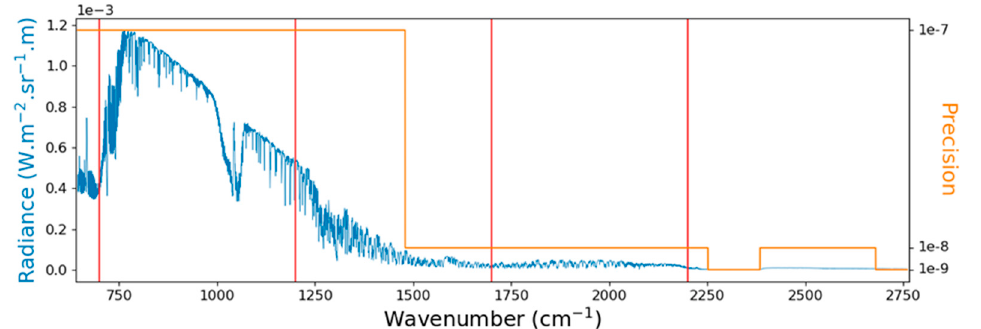
Figure 1. The Infrared Atmospheric Sounding Interferometer (IASI) typical radiance spectrum (left axis) superimposed with the precision used by the EUropean organisation for the exploitation of METeorological SATellites (EUMETSAT) (right axis), making the precision of the radiance values dependent on the wavenumber. The vertical red lines are the wavenumbers at which the differences were computed.